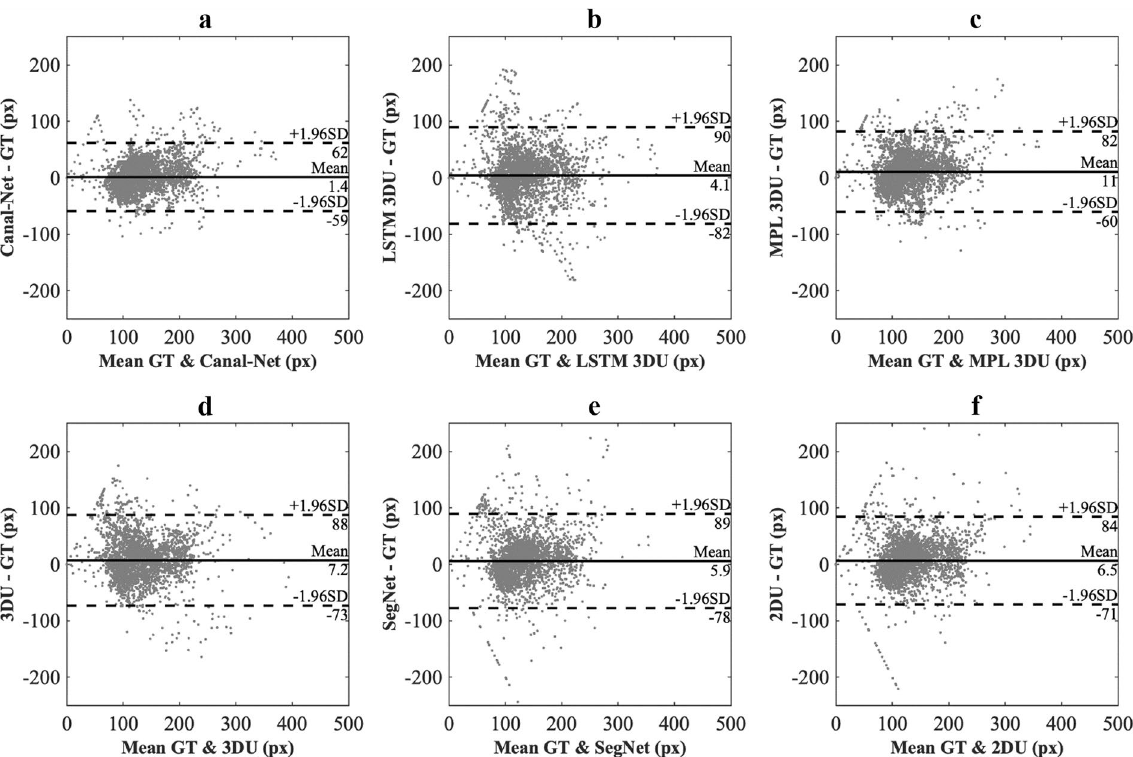
Figure 7. The Bland–Altman plots between the ground (GT) and prediction results from the ( a ) Canal-Net, ( b ) convLSTM 3D U-Net (LSTM 3DU), ( c ) MPL 3D U-Net (MPL 3DU), ( d ) 3D U-Net (3DU), ( e ) SegNet, and ( f ) 2D U-Net